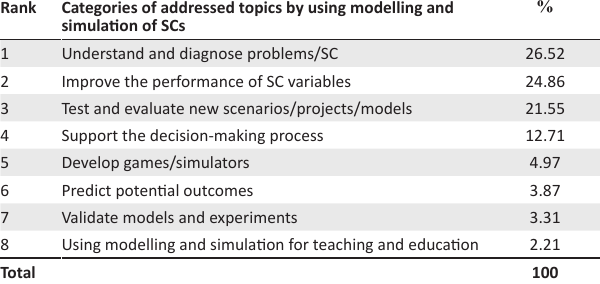
TABLE 2: Most frequently studied topic areas in the literature review of Oliveira et al. – with own interpretation. Rank Categories of addressed topics by using modelling and simulation of